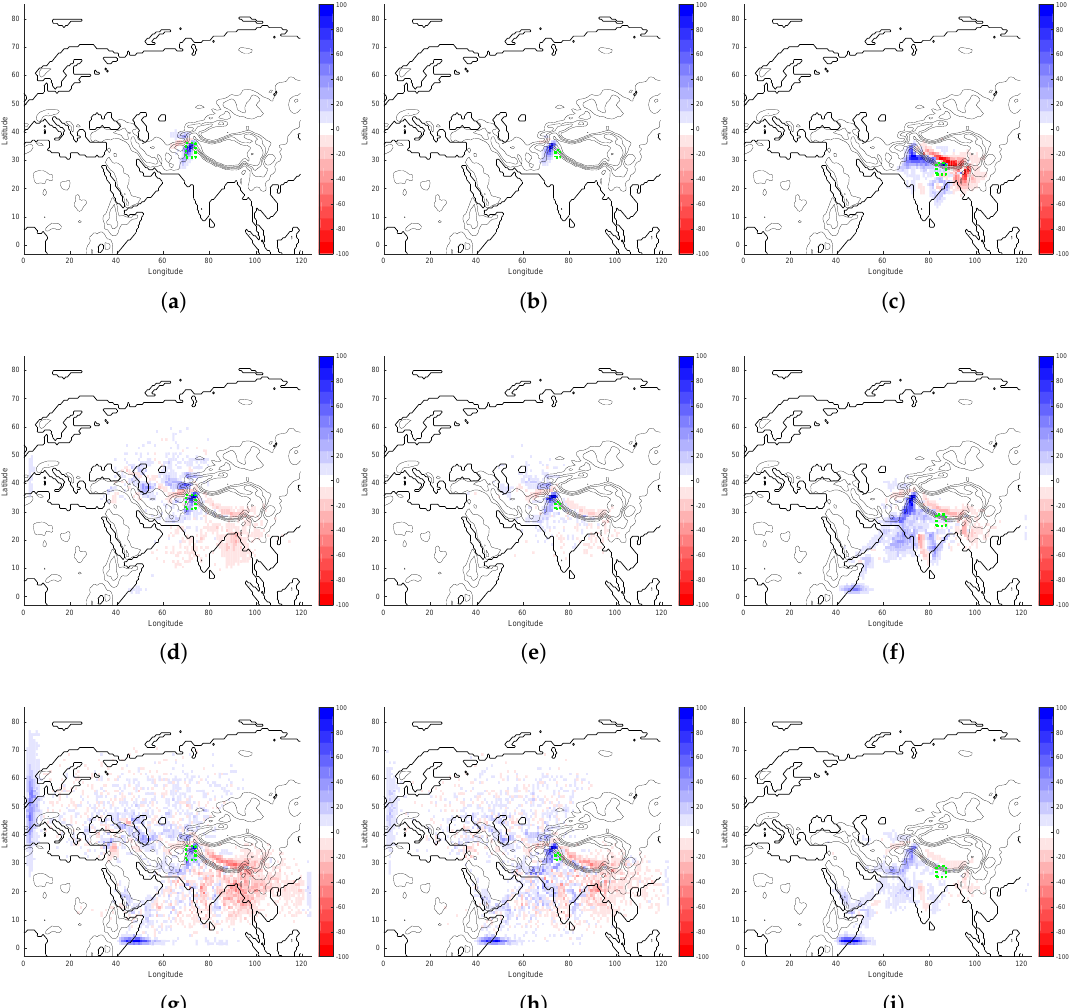
Figure 4. Summer (JJA) column integrated climatology (1980–2016), of the moisture sources and sinks, for all parcels over each 1 ◦ area, originating from: ( a ) NP , 2 days back in time, along the parcel trajectory; ( b ) U , 2 days back in time, along the parcel trajectory; ( c ) K , 2 days back in time, along the parcel trajectory; ( d ) NP , 6 days back in time, along the parcel trajectory; ( e ) U , 6 days back in time, along the parcel trajectory; ( f ) K , 6 days back in time, along the parcel trajectory; ( g ) NP , 10 days back in time, along the parcel trajectory; ( h ) U , 10 days back in time, along the parcel trajectory; ( i ) K , 10 days back in time, along the parcel trajectory. The area of interest is illustrated by a green dashed box. The colour bar scale shows the relative difference of the change in specific